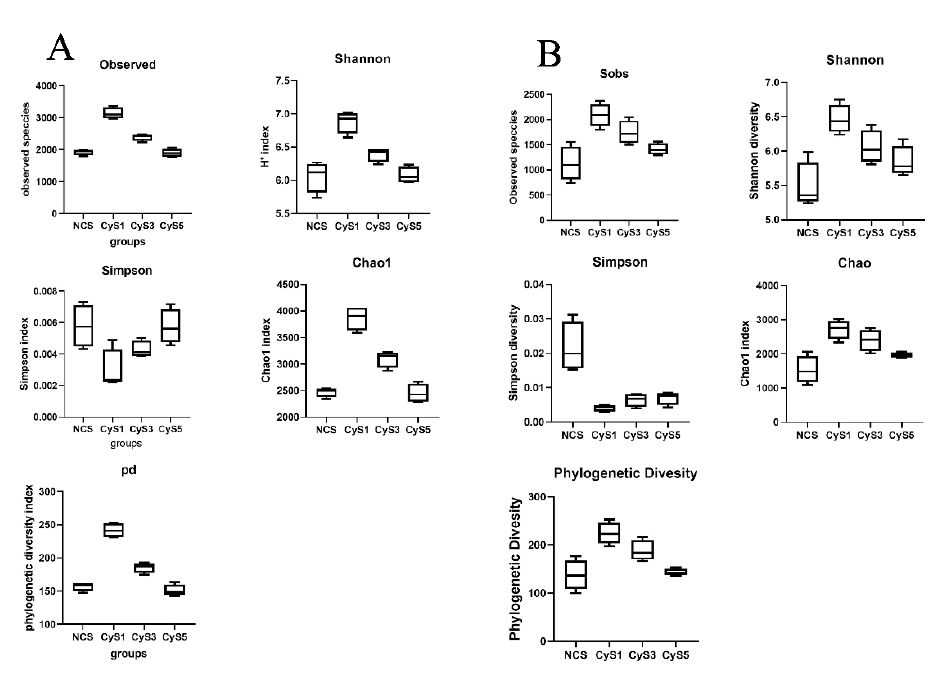
Figure 2. Box plots showing alpha diversity (Sobs, Chao, Shannon, phylogenetic diversity, and Simpson Index) variation across samples in winter ( A ) and summer ( B ). NCS, fallow field soil; CyS1, one-year C. chinensis cultivated soil; CyS3, three-year C. chinensis cultivated soil; CyS5, five-year C. chinensis cultivated soil.